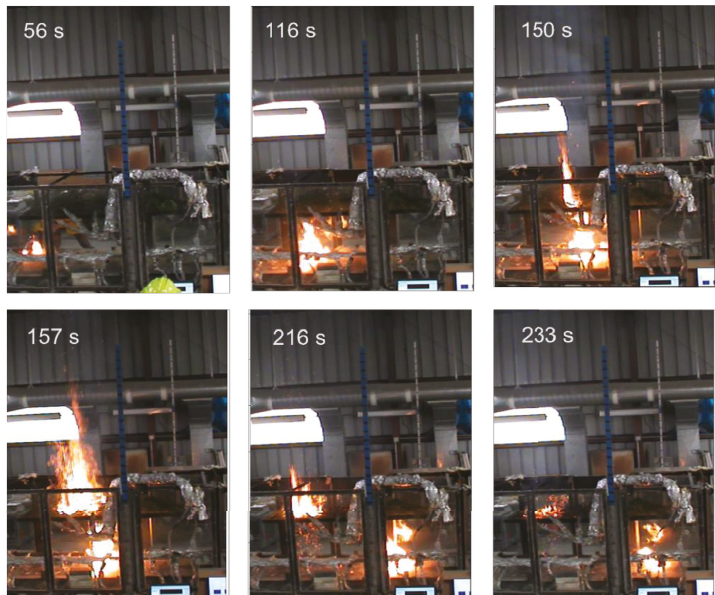
Figure 8: Special case of marginal spread at CBH � 0.7 m and no wind. The progression of images extracted from the experiment video shows the transition location, the development of the crown flame, and the eventual natural extinguishing of the flame which leaves a considerable portion of the fuel bed